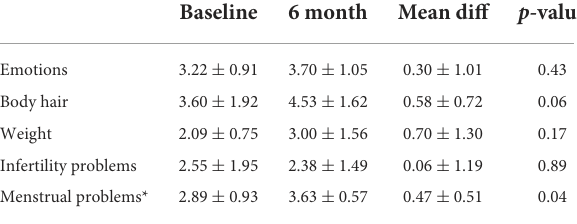
TABLE 3 Changes in PCOS related quality of life ( n =